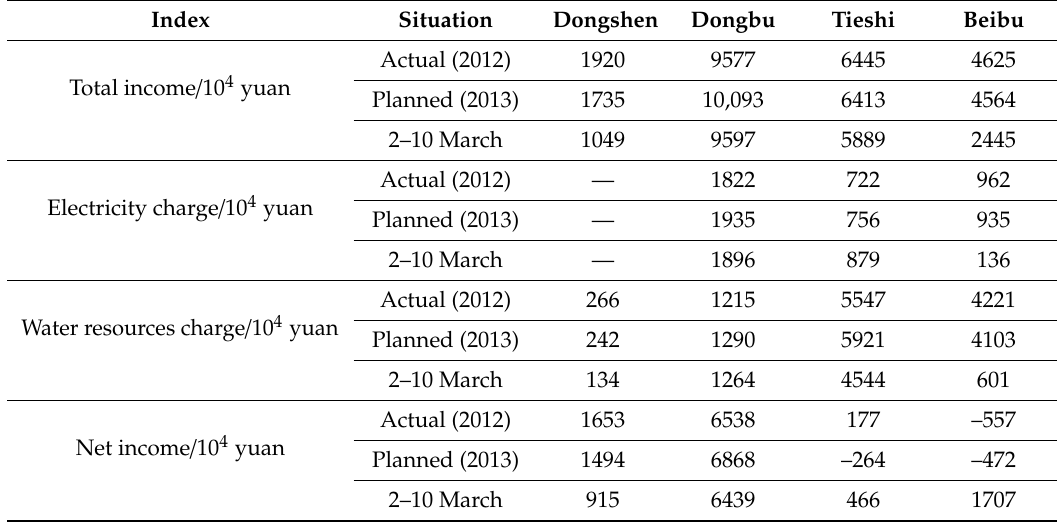
Table 10. The total income, electricity charge, water resources charge and net income of four water management units during the period of 2–10 March under three situations (Actual 2012, Planned 2013, Simulated